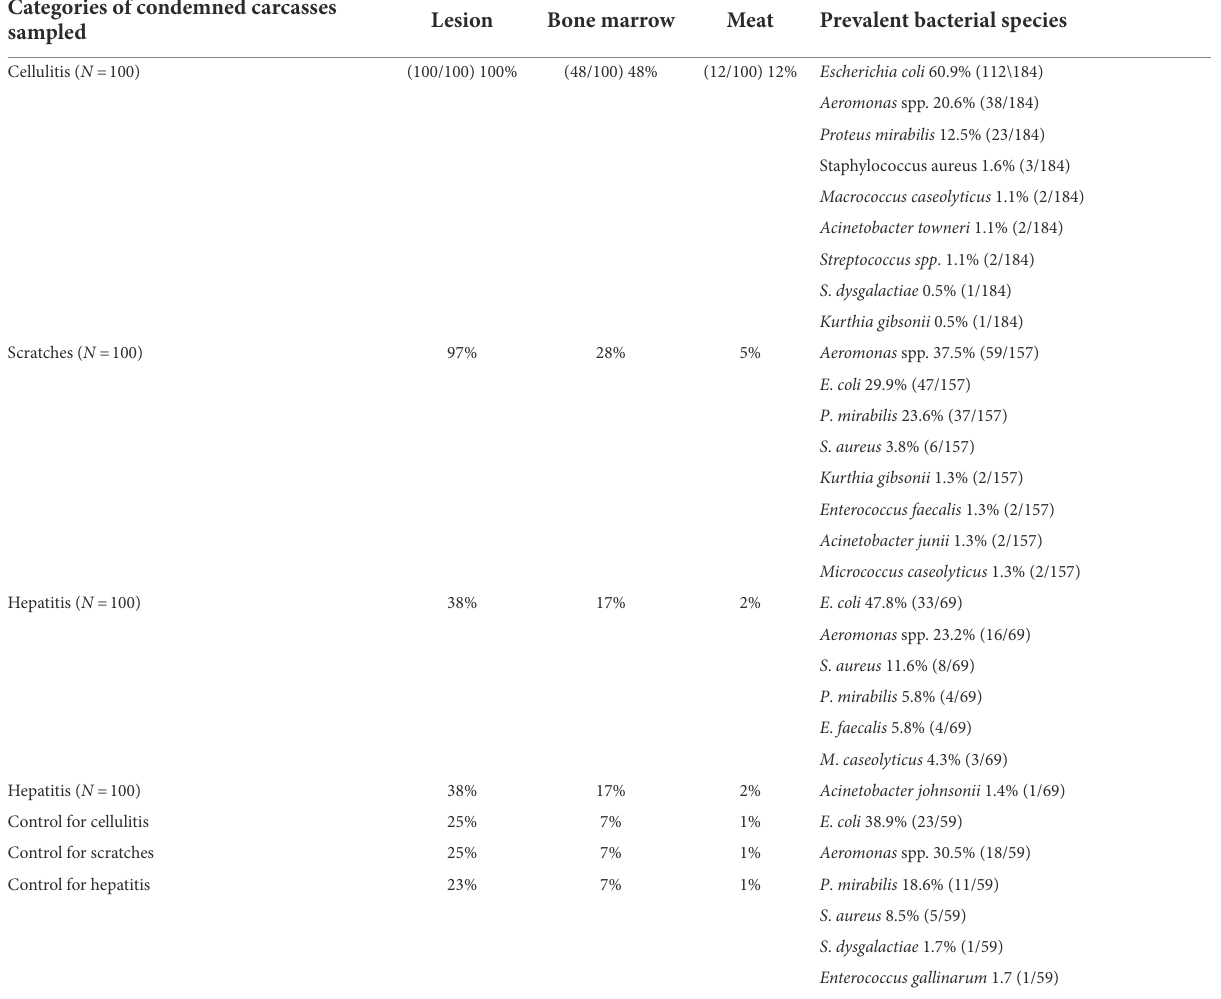
TABLE 1 Prevalence and bacterial species isolated from 400 samples of broilers condemned with cellulitis, scratches, hepatitis, and healthy control carcasses. Categories of condemned carcasses